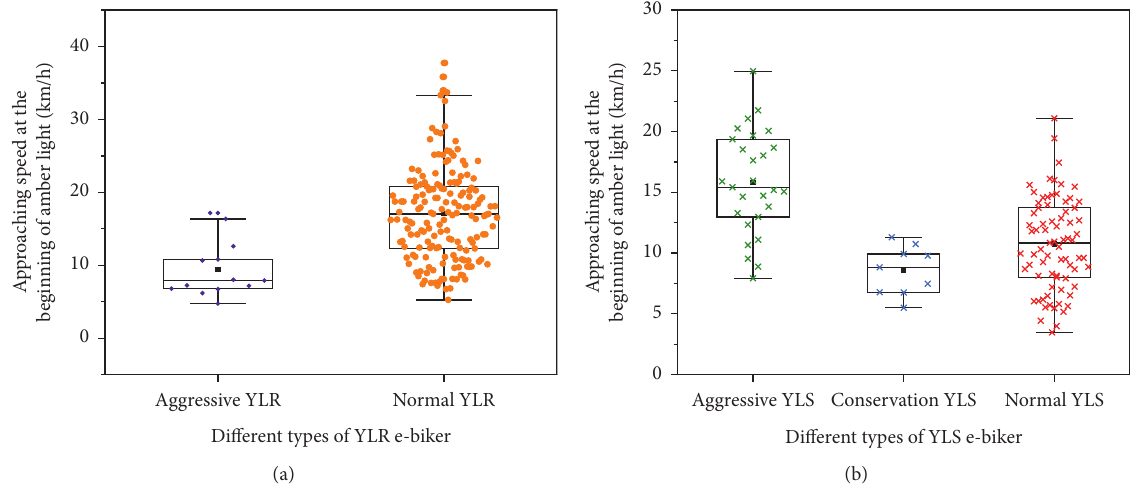
Figure 7: Box plots of approaching speed for different types of YLR and YLS